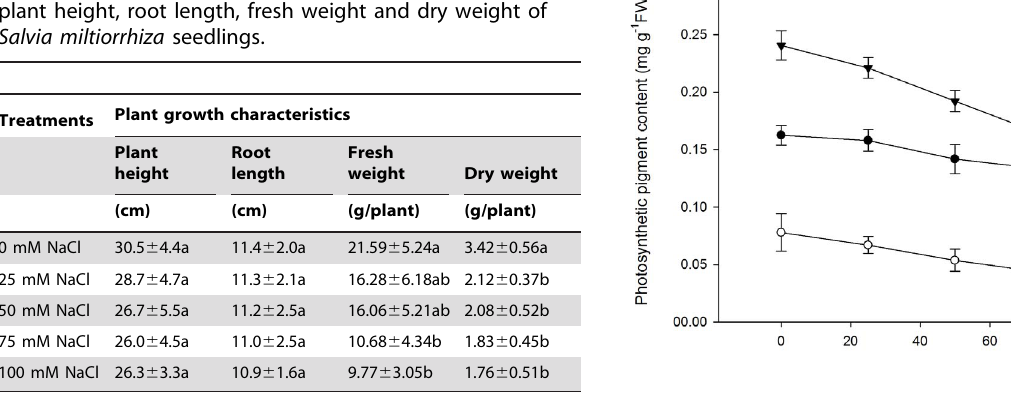
Table 1. The effects of various NaCl concentrations on the plant height, root length, fresh weight and dry weight of Salvia miltiorrhiza seedlings.